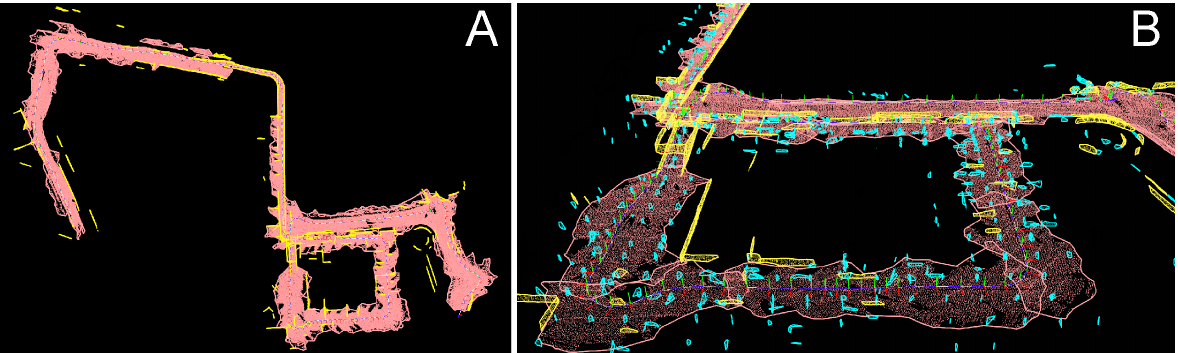
Figure 18. Visualization of the entire global map built by PlaneLOAM during the Posnania experiment ( A ), and a close-up view of its central fragment ( B ) showing a detailed structure of the underground parking lot with walls (yellow), smaller vertical elements, such as pillars (cyan) and the ground plane